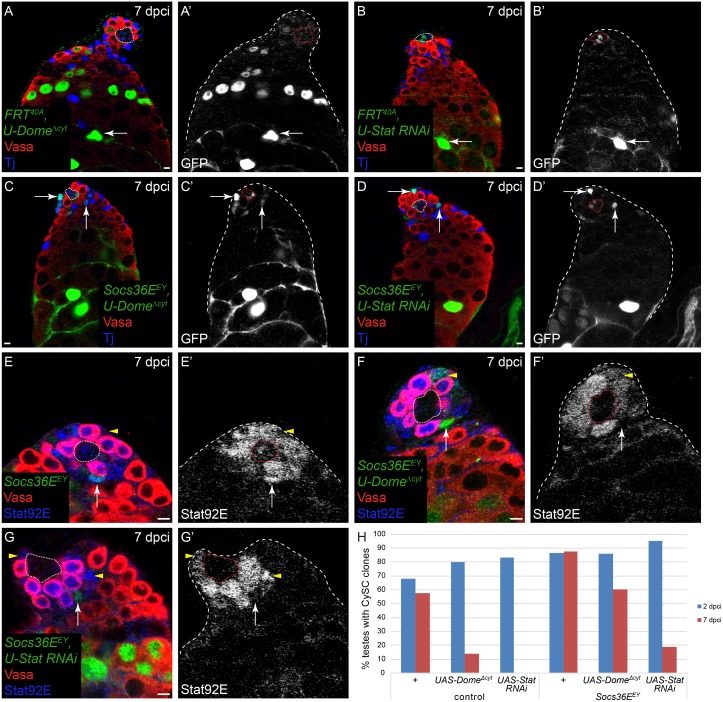
Socs36E mutant CySCs can self-renew without JAK/STAT signaling.All clones were generated by the MARCM technique and are positively-marked by the expression of GFP. A,B) CySC clones that express a dominant-negative form of Dome (DomeΔcyt) (A), which inhibits JAK/STAT signaling, or that are depleted for Stat92E (UAS-Stat RNAi) (B), are not recovered at 7 dpci. However, their differentiating cyst descendants are observed at this time point (A’,B’, arrow). C,D) By contrast, when Socs36E is also removed from DomeΔcyt (C, arrows) or from UAS-StatRNAi (D, arrows) CySC clones, these clones are now maintained as stem cells. E) Socs36E clones have elevated levels of Stat92E (E,E’, arrow) compared with wild type CySCs (E,E’, arrowhead). Note that GSCs have higher levels of stabilized Stat92E protein than wild type CySCs. F) Some Socs36E, DomeΔcyt CySCs have residual levels of stabilized Stat92E (F,F’, arrowhead) and some have undetectable levels of stabilized Stat92E (F,F’, arrow). G) Socs36E, UAS-Stat RNAi CySCs have undetectable Stat92E levels (G’, arrow) whereas wild type CySCs in the same testis have moderate to high levels of Stat92E (G’, arrowheads). H) Graph of CySC clone recovery rates at 2 (blue bars) and 7 (red bars) dpci. CySCs expressing DomeΔcyt or UAS-Stat RNAi are not recovered at 7 dpci. By contrast, Socs36E, UAS-DomeΔcyt CySCs are recovered at robust levels at 7 dpci. Socs36E, UAS-StatRNAi CySCs are maintained at moderate levels at 7 dpci. Vasa is red in A-G. Tj is blue in A-D and Stat92E is blue in E-G. The hub is outlined by a dotted line. Scale bar = 5 μM.